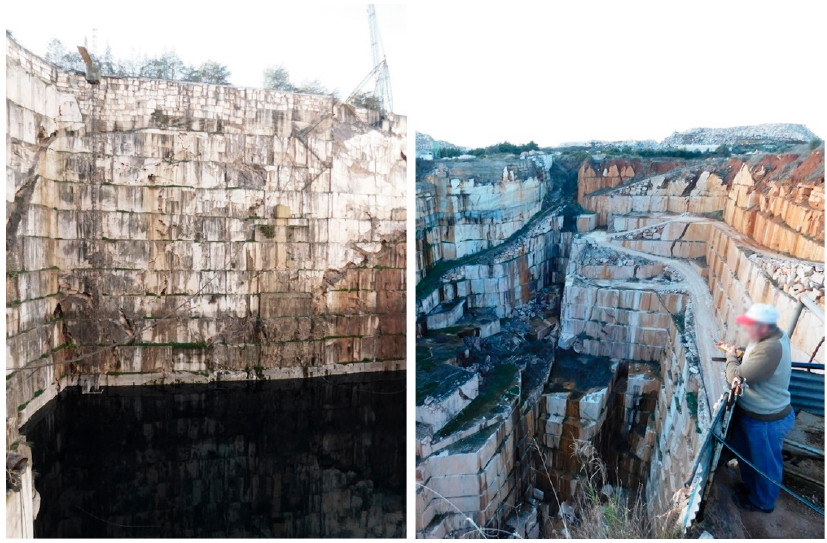
Figure 5. Abandoned marble quarries in the Anticlinal of “Estremoz”, Portugal. Note the waste mounds in the background. mounds in the